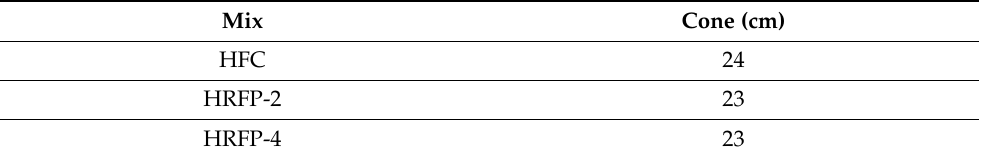
Table 4. Concrete workability results.